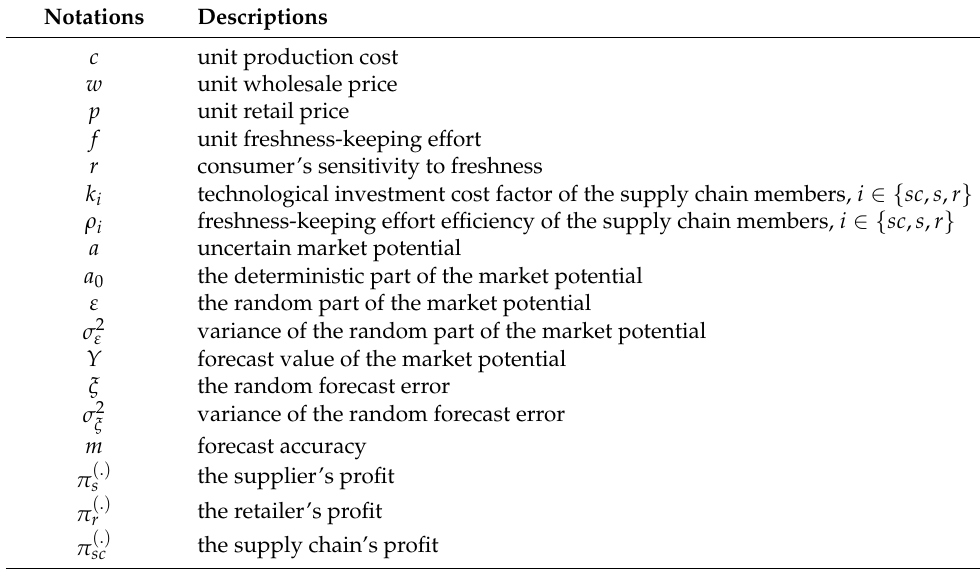
Table 2. Notations and